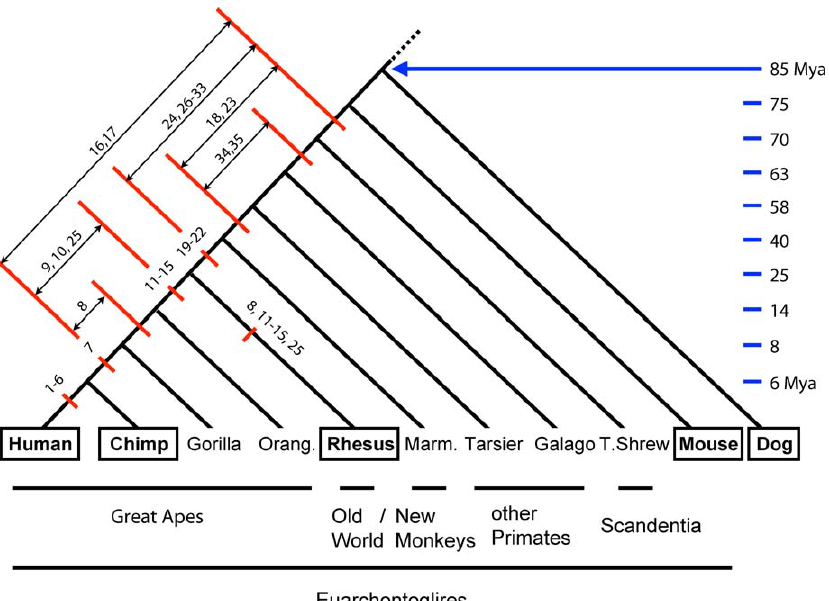
Figure 3. Timing of the Gene Losses in the Human Lineage Since the Common Ancestor of Euarchontoglires, Estimated Based on Shared Mutation Analysis Branch intervals enclosing the earliest ORF-disrupting mutations shared between human and other mammals are illustrated on the human lineage of a mammalian species tree. Genes are represented by numbers, which correspond to their row numbers in Tables 1 and 2. Marks on the rhesus lineage represent independent ORF-disrupting mutations that are not shared with the ones in the human lineage. Approximate time when the species diverged from the human lineage is shown in Mya. Species with complete genome sequences are enclosed by rectangles, while others only have trace sequences available for analysis. Orang.: orangutan; Marm.: marmoset; T.shrew: tree shrew.